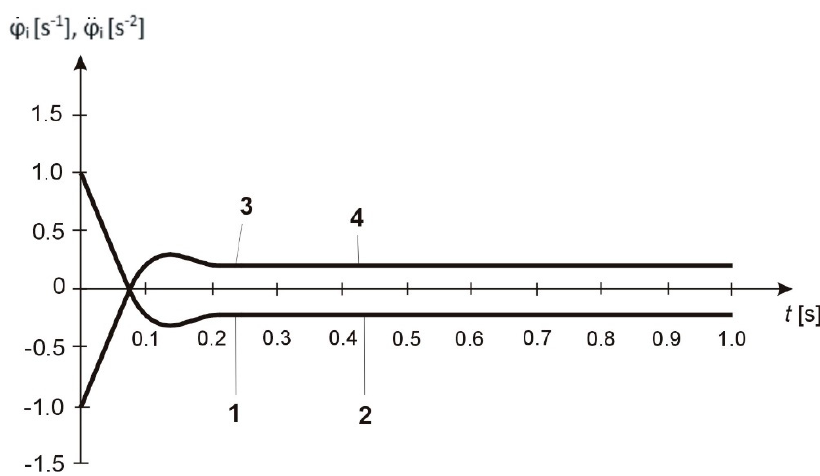
Figure 5. Graph of changes in the function of angular velocities—1, 3 and angular accelerations—2, 4 of the shaft for: 1, 2— u ( t ) = + 1; 3, 4— u ( t ) = − 1.